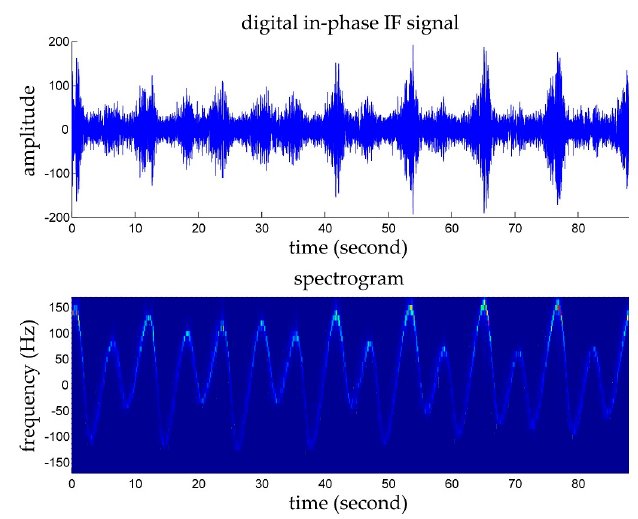
Figure 18. Two ocean waves. The highest points and the lowest points are 1.185 m and − 1.185 m and located in the dark red areas and the dark blue areas, respectively.